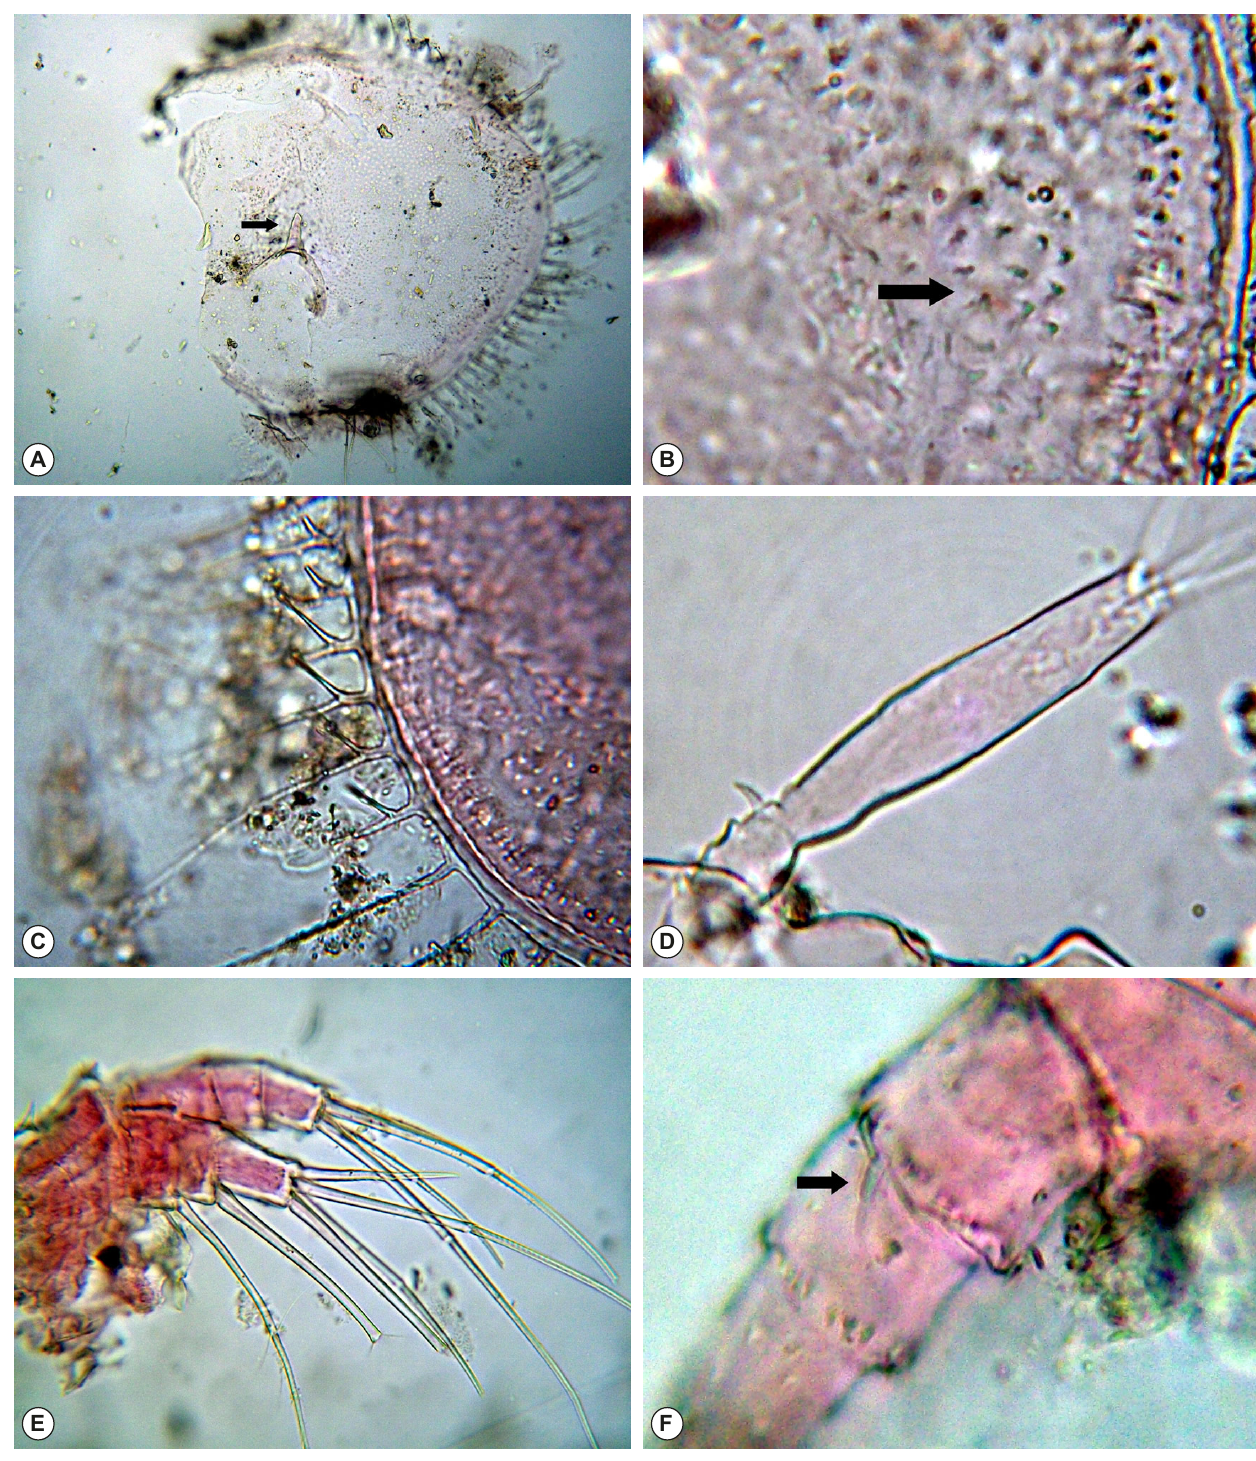
Figure 4. Ilyocriptus paranaensis paranaensis . A. Valve. B. Margin on inner surfaces of valve. C. Posterior margin of the valve. D. Antennules. E. Antenna. F. Second segment exopod of